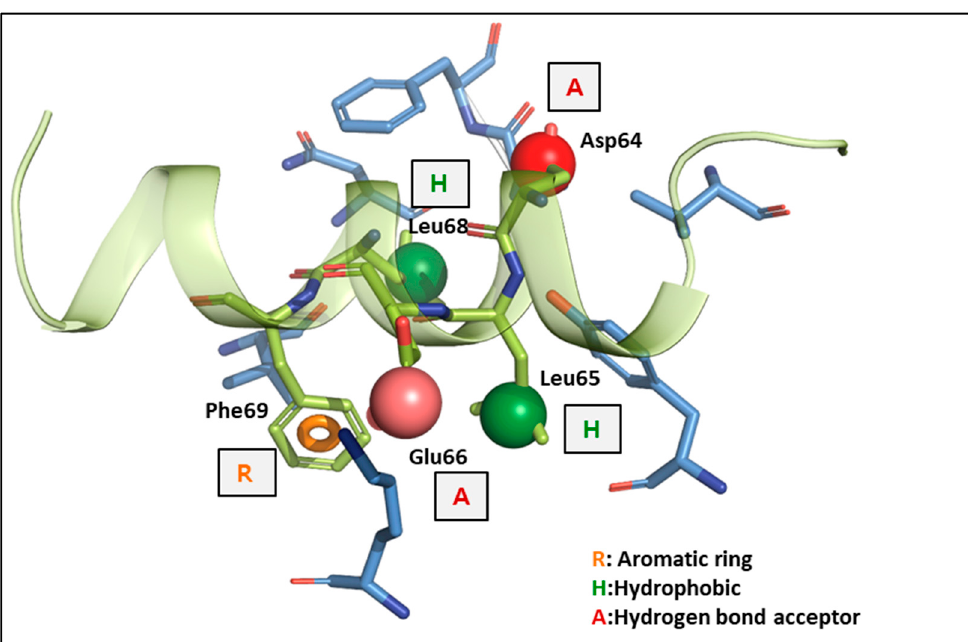
Figure 4. Pharmacophore models derived from the hot spot at interface 2 of YAP–TEAD PPIs. R, aromatic ring; H, hydrophobic; A, hydrogen bond acceptor. The green helix and sticks represent the YAP region, and the light blue stick represents the TEAD1 region.